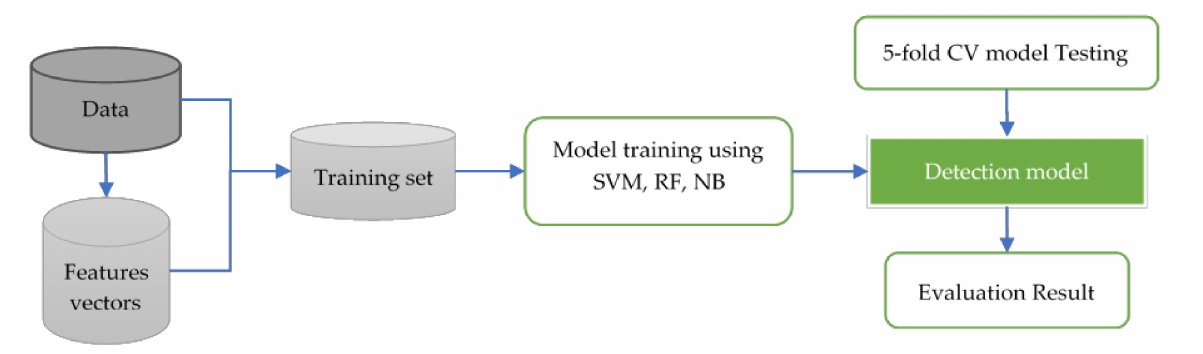
Figure 4. The model building flow